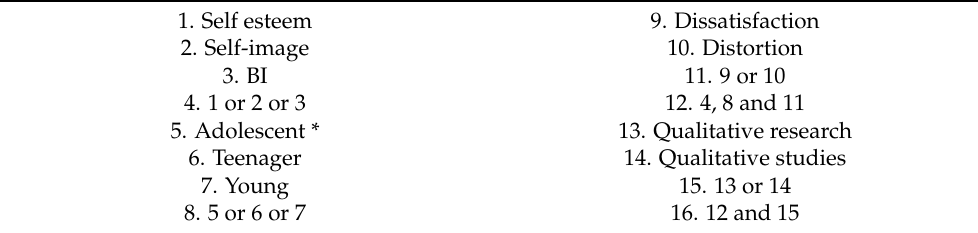
Table 2. Database search